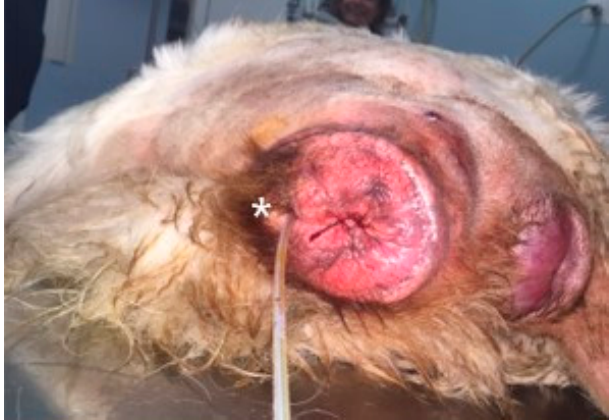
Figure 6 . Type III vaginal hyperplasia, with urethral involvement (*) in the prolapsed mass. Urethral catheterization was performed prior to prolapse reduction and vulvar suturing.